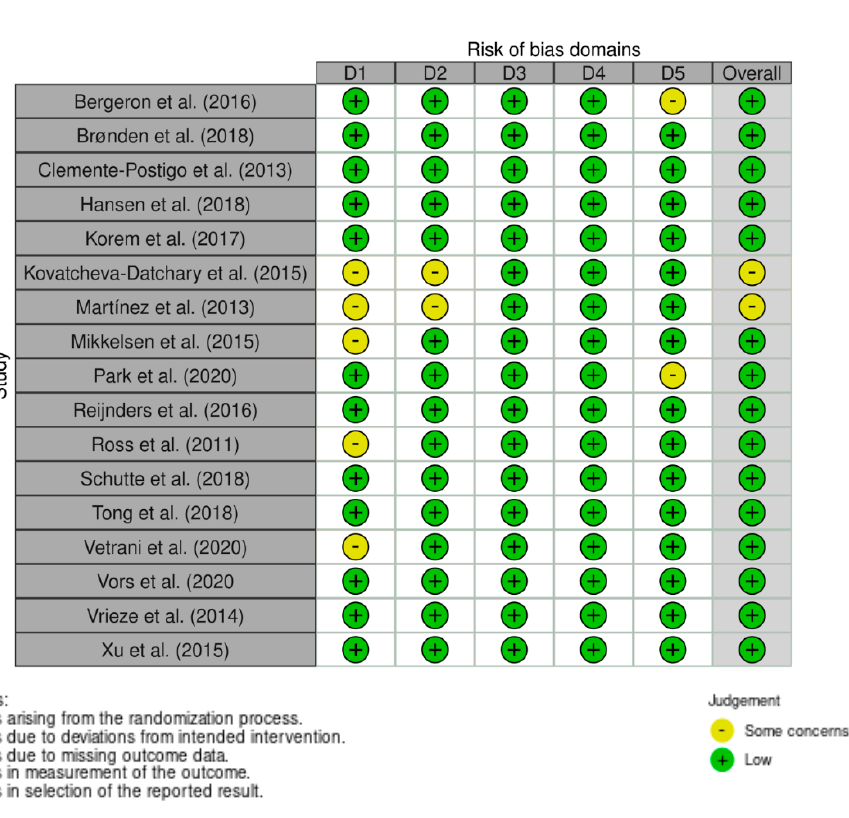
Figure 2. Quality assessment of included randomised trials ( n = 17) using the Cochrane Risk of Bias Tool.